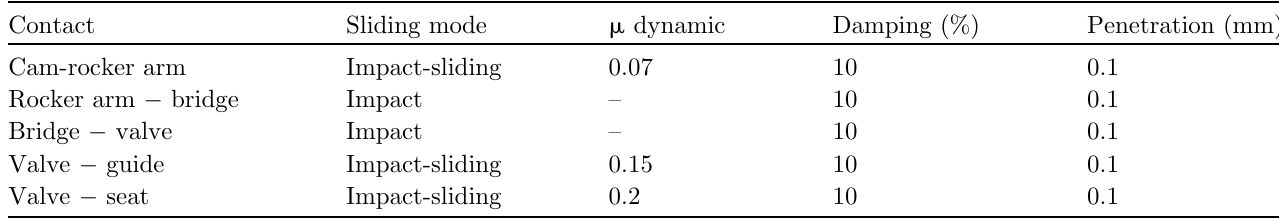
Table 2. Parameters for contact management in the valve train.